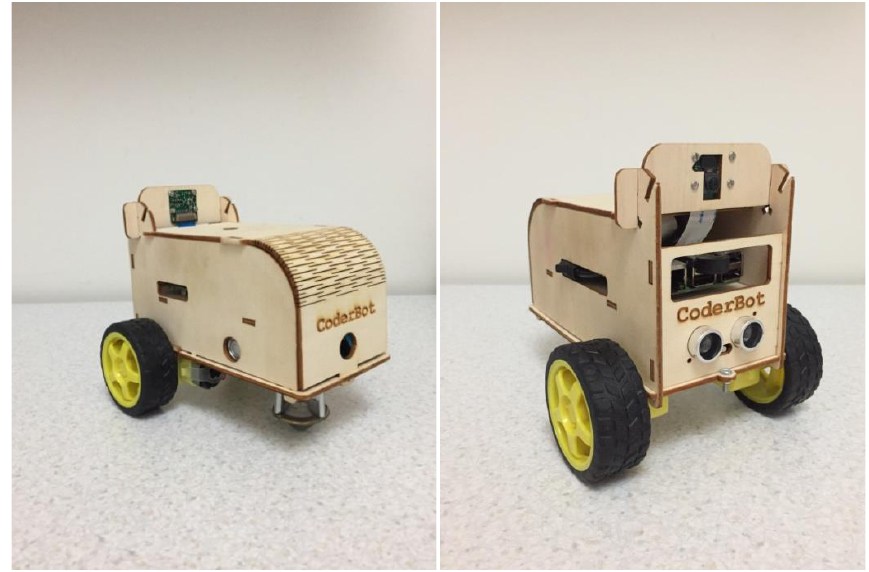
Figure 1. CoderBot Images.